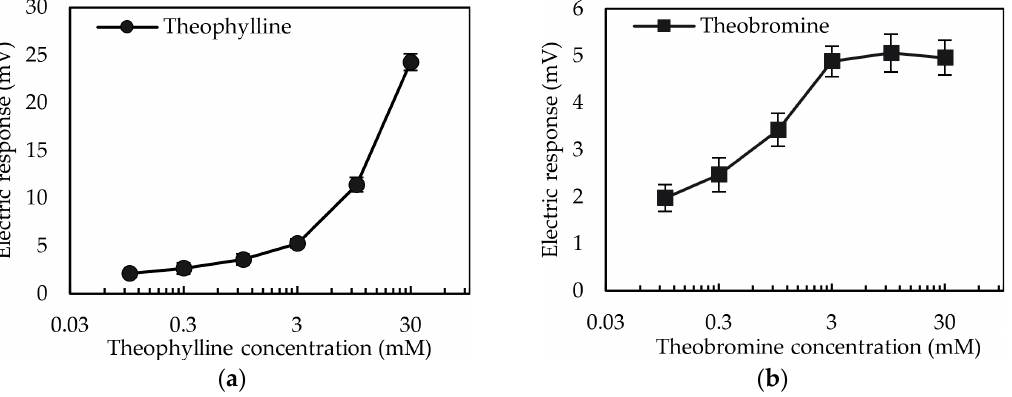
Figure 10. Concentration characteristics of each caffeine analog obtained with 3 mM TDAB membrane modified with 0.03 wt% 3-Br-2,6-DHBA: ( a ) Theophylline; ( b ) theobromine. The error bar indicates the SD of data, n = 8 (electrode) × 1 (rotation) = 8 values.